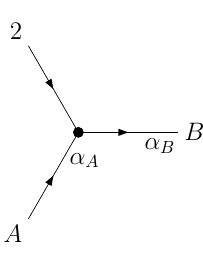
Figure 3 . Vertex showing example of how to truncate geometric series. Here we take leg 2 to be external (with the corresponding edge variable set to 1) and legs A and B to be